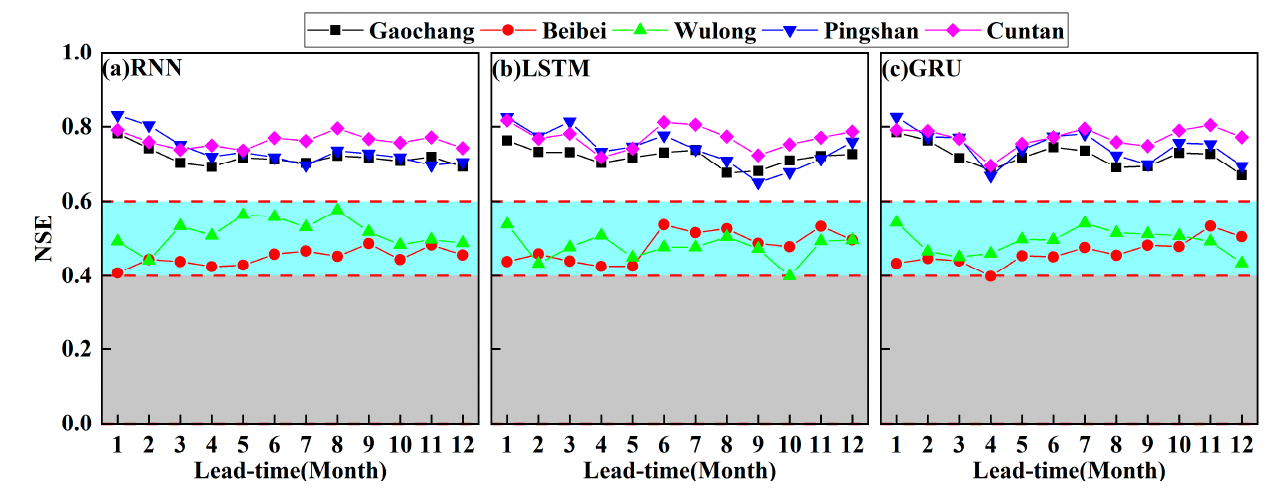
Figure 12. The performance of runoff prediction at the lead times of 1–9 months by ( a ) RNN, ( b ) LSTM, and ( c ) GRU models with optimal time lags.